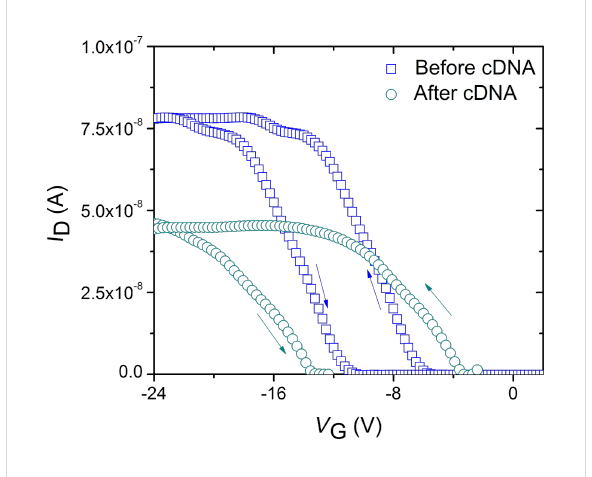
Figure 3: I D – V G curves of SWCNT-based FETs with the channel and junction exposed to cDNA ( L = 300 µm). The “before cDNA” step corresponds to the recording obtained after PASE, probe DNA, EA and Tween 20 incubation steps. The “after cDNA” step represents the recording after incubation with cDNA. The arrows indicate the direc- tion of the gate voltage